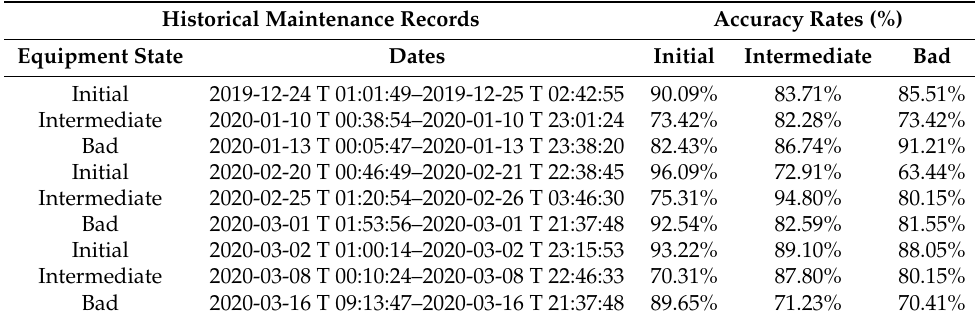
Table 8. LSTM-autoencoders accuracy rates.